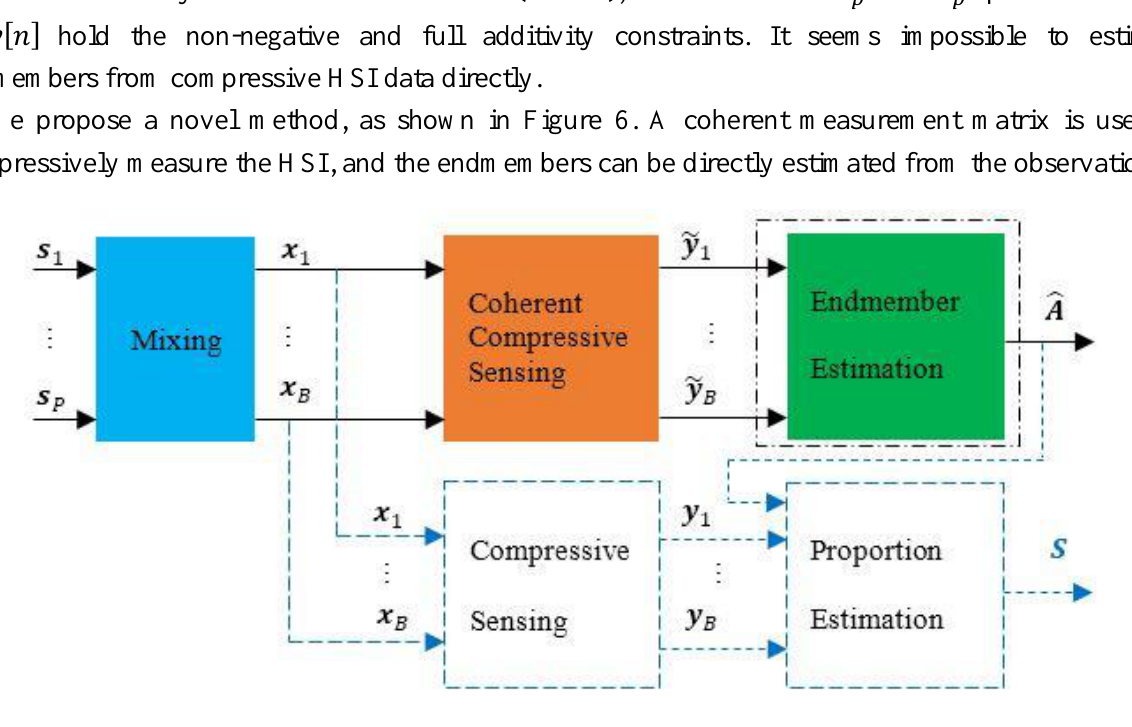
Figure 6. The framework of the proposed